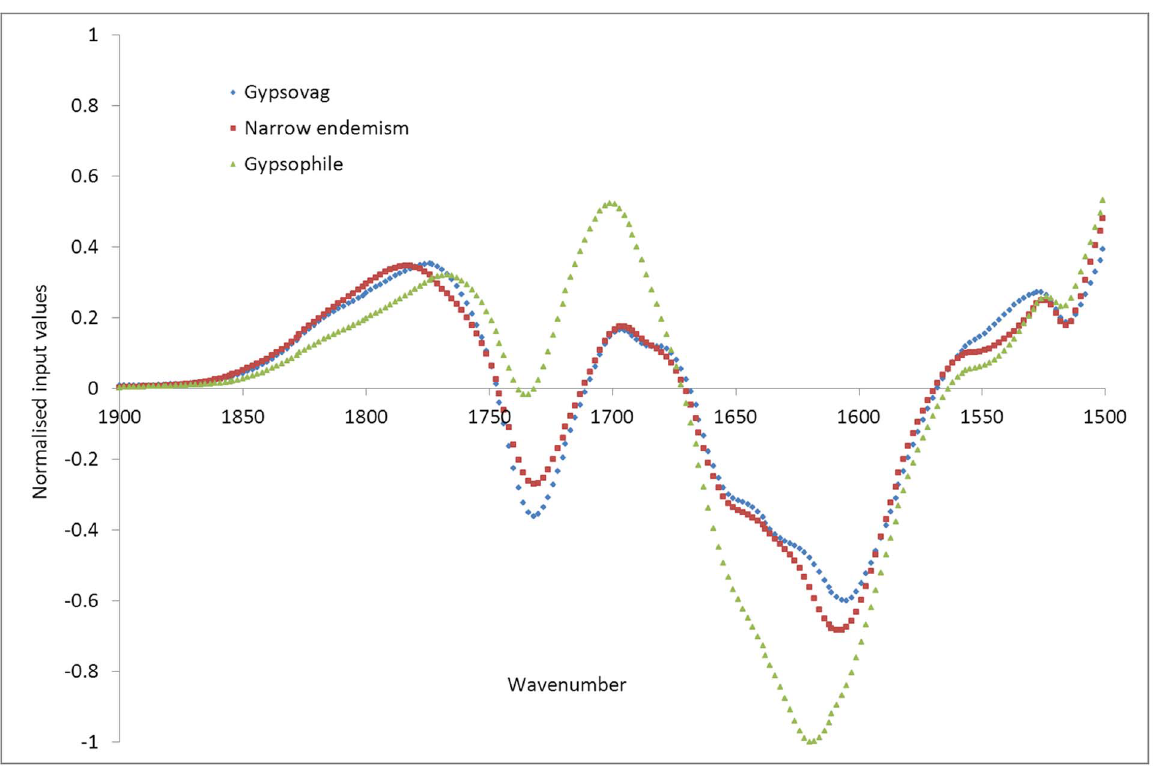
Figure 5. Input datasets averaged over each of the plant types (gypsovags in blue, narrow gypsum endemisms in red, wide gypsophiles in green), for the input wavenumber range 1500 to 1900 cm 2 1 .